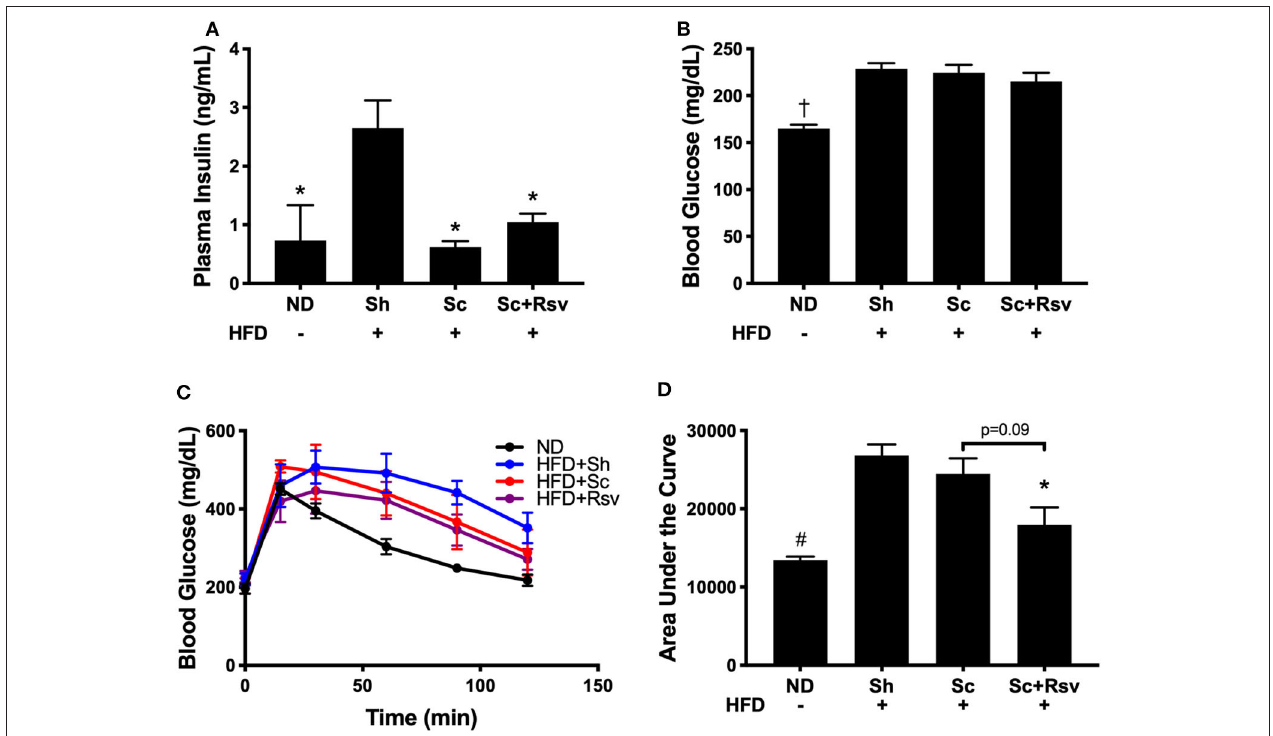
FIGURE 3 | Fasting insulin and glucose levels and glucose tolerance 5 weeks after scaffold delivery in mice fed a high fat diet. (A) Fasting insulin measured in plasma by ELISA. (B) Fasting glucose measured in whole blood by glucometer. (C) Blood glucose vs. time during an intraperitoneal glucose tolerance test and (D) area under the curve. Statistics were calculated by one-way ANOVA with a Tukey’s multiple comparisons test. * p < 0.05 vs. HFD + Sh. † p < 0.05 vs. HFD + Sh, HFD + Sc, and HFD + Rsv. # p < 0.05 vs. HFD + Sh and HFD + Sc. n = 5 mice per group.